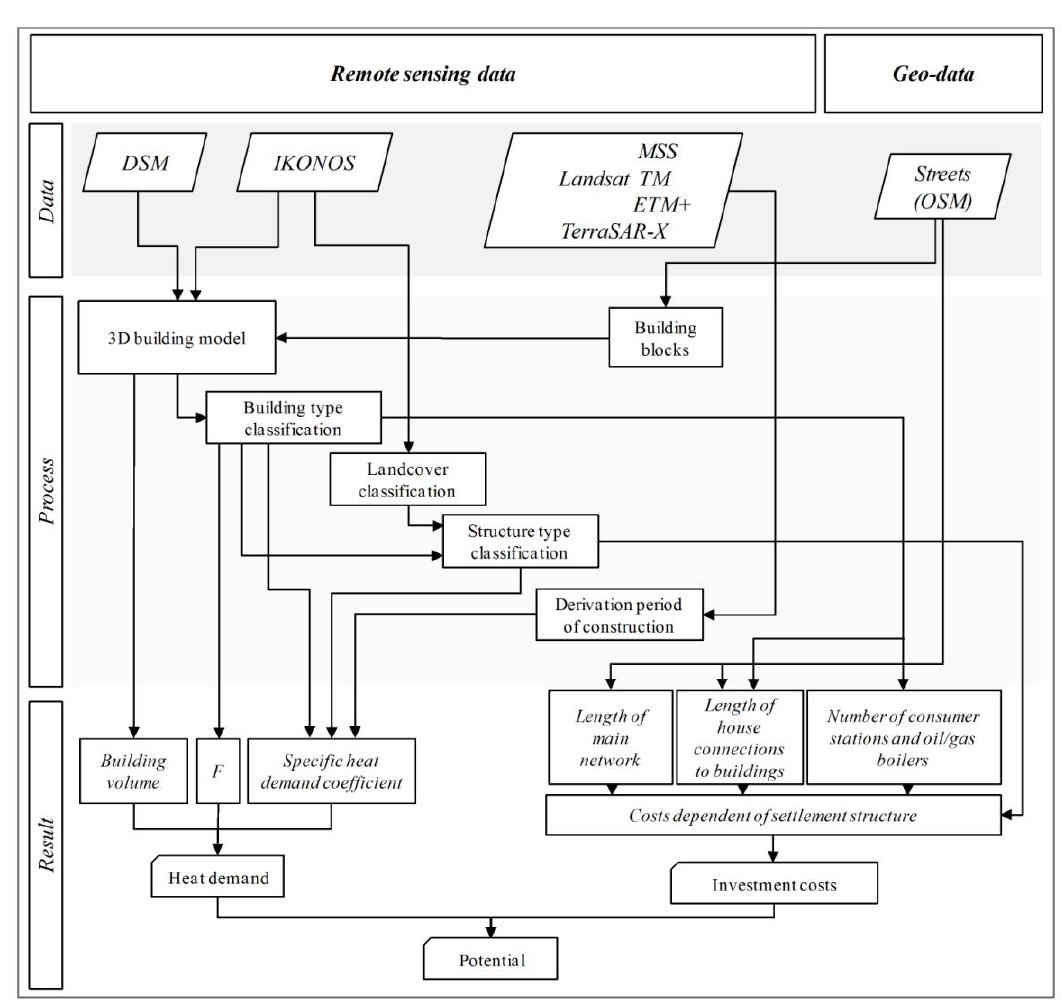
Figure 1. Data base and processes for the calculation of district heating